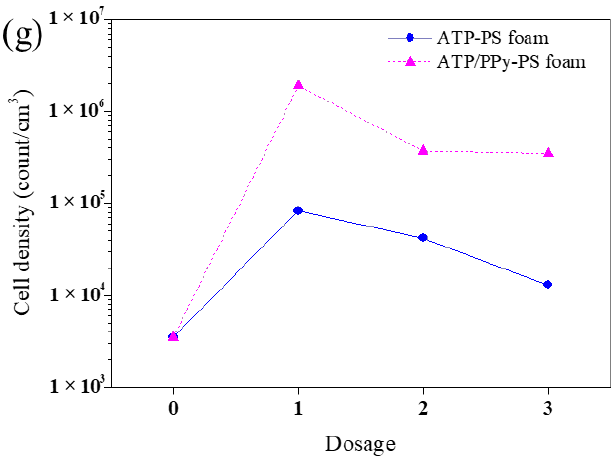
Figure 4. The optical microscopy images showing the cell size and cell density of ( a ) neat PS foam, ( b ) ATP-PS 3 and ( c ) ATP/PPy-PS 3, scale bar: 500 μm. Top view scanning electron microscopy (SEM) micrographs of ( d ) neat PS foam, ( e ) ATP-PS 3 and ( f ) ATP/PPy-PS 3, scale bar: 2 μm. ( g ) Cell density test of ATP-PS foam and ATP/PPy-PS foams. Table 1. Density and morphological properties of neat PS foam, ATP-PS foam, and ATP/PPy-PS foam.